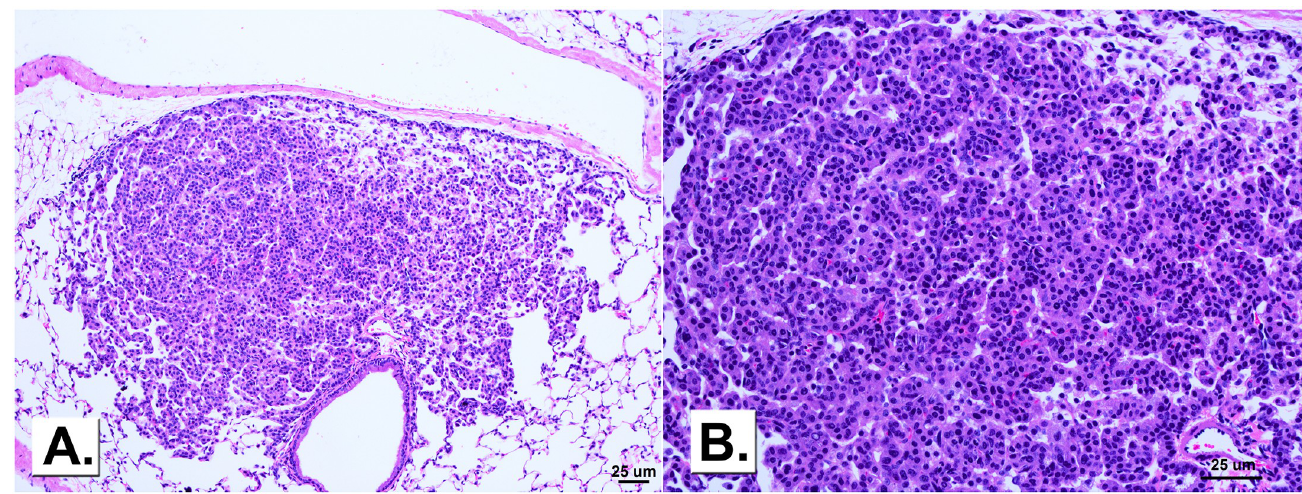
Fig 10. A bronchiolo-alveolar adenoma in an Fe 2 O 3 -exposed mouse 30 weeks post-initiation with MCA at 10x magnification (panel A) and 20x magnification (panel B).